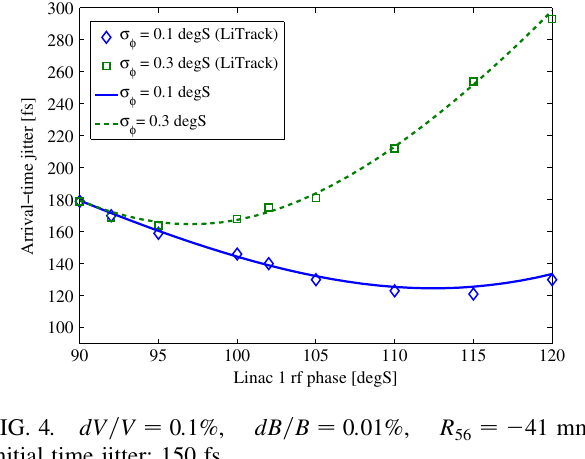
FIG. 4. dV=V ¼ 0 : 1% , dB=B ¼ 0 : 01% , R 56 ¼ (cid:3) 41 mm . Initial time jitter: 150 fs.